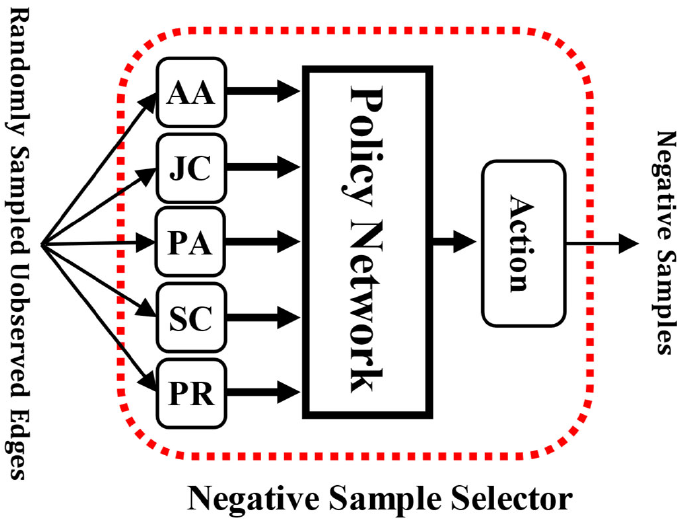
Figure 3. The architecture of the negative sample selector. The conceptions of the AA, JC, PA, SC, PR, and Action are introduced in Sections 3.1 and 3.2.